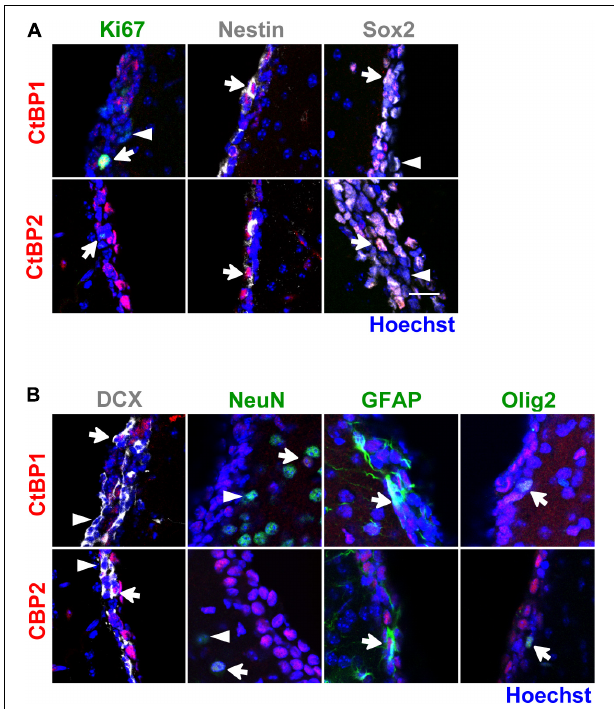
FIGURE 3 | CtBP1 and CtBP2 are expressed in immature/progenitor cells, neuroblasts and glial cells in the SVZ neurogenic niche in vivo . (A,B) Representative confocal images of the expression of CtBPs in (A) proliferating (Ki67) and immature cells (Nestin, Sox2), and in (B) neuroblasts (DCX), mature neurons (NeuN), astrocytes (GFAP), and oligodendrocytes (Olig2), evaluated in the SVZ niche of wild-type C57BL/6J adult mice. Nuclei are shown in blue. White arrows highlight cells with double staining whereas arrowheads highlight cells that do not express CtBP1 or CtBP2. Scale bar: 20 µ